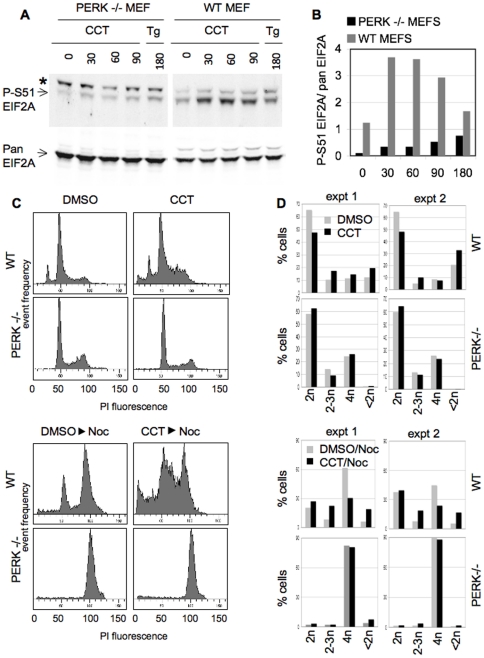
Effects of CCT020312 exposure on wild type and PERK KO MEFs.
A) EIF2A phosphorylation. SV40-immortalised wild type (WT) and PERK KO MEFs (PERK−/−) were treated with 10 µM CCT020312 (CCT), 2 µM thapsigargin (Tg) for the time indicated. Cell lysates were analysed using P-S51 EIF2A and pan EIF2A selective antibody. The position of P-S51 EIF2A is indicated with an arrow beneath an unrelated, high molecular weight, non-specific band (*). B) Signal quantification for data shown in A). Charts depict the background corrected signal for P-S51 EIF2A relative to that of pan EIF2A in the same samples. Signals were quantified using Image J. C) Cell cycle response. MEFs were treated with 10 µM CCT020312 or vehicle (DMSO) for 30 hrs and analysed for cell cycle distribution. Where indicated, Nocodazole (Noc) was added to the culture medium at a concentration of 1 µg/ml for the final 16 hours. Raw propidium iodide profiles are shown. Cells were treated in parallel to those analysed for A. D) Quantitative analysis of cell cycle distribution. Experiments were as described for C). Charts depict the percentage of cells with DNA content as indicated, nocodazole was added where indicated. Results for two independently run experiments are shown.